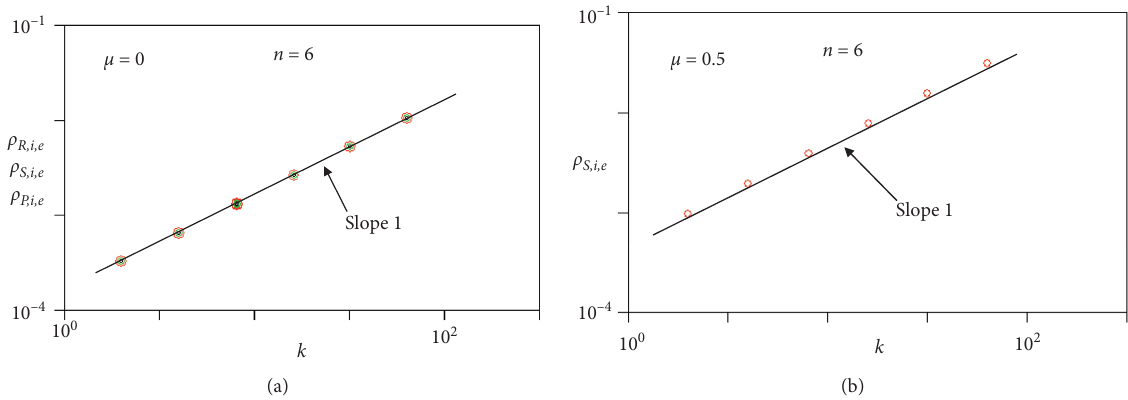
Figure 3: (a) Log-log plot of RPS densities against node’s degree k at mutation rate μ � 0 for generation number n � 6 where highest degree is 2 6 . Black, red, and green circles indicate RSP densities in the limit of μ � 0, respectively. The RSP densities are on the linear line with slope 1. (b) Log-log plot of S densities against node’s degree k at mutation rate μ � 0 . 5 for generation number n � 6. Red circles indicate S densities at μ � 0 . 5. The S densities are on the linear line with slope